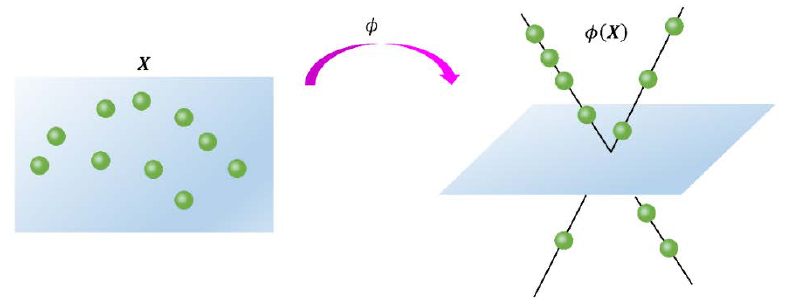
Figure 1. Nonlinear mapping in the proposed method.